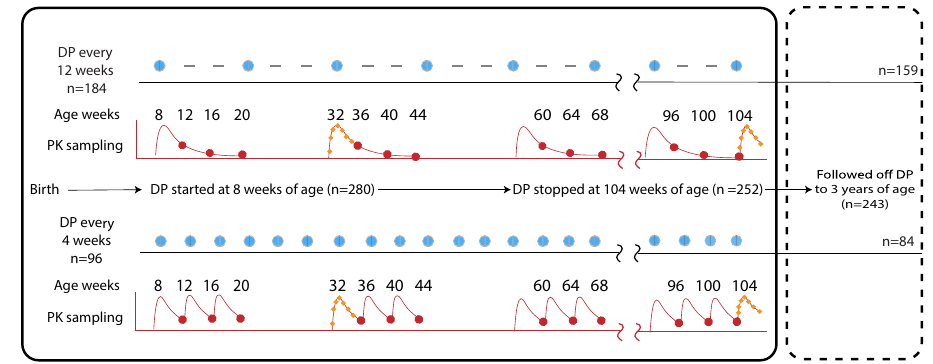
Fig. 1 Summary of trial interventions and sampling for piperaquine concentrations. Blue dots indicate dihydroartemisinin-piperaquine (DP) courses dispensed, and dashes indicate episodes when a placebo was given. The red dots indicate sparse pharmacokinetic (PK) sampling for piperaquine concentrations (all participants contributed data) and red lines indicate typical pharmacokinetic pro fi les. Intensive sampling, in orange dots, occurred at 32 and 104 weeks (22 individuals in every 12 weeks and 10 in the every 4 weeks arm).